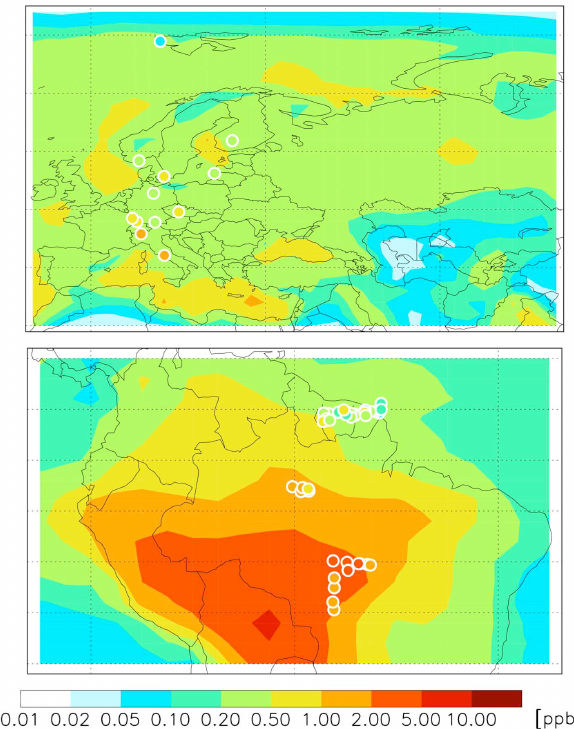
Fig. 8. Acetaldehyde in the boundary layer ( P> 800hPa) over Eu- rope and South America. Top: simulated concentrations over Eu- rope in July–August are compared to an ensemble of surface mea- surements during those months (Slemr et al., 1996; Solberg et al., 1996; Christensen et al., 2000; Bartenbach et al., 2007; Lappalainen et al., 2009). Bottom: simulated concentrations over South Amer- ica during September-October are compared to aircraft and surface measurements from the GABRIEL (Eerdekens et al., 2009) and TROFFEE (Karl et al., 2007) campaigns.